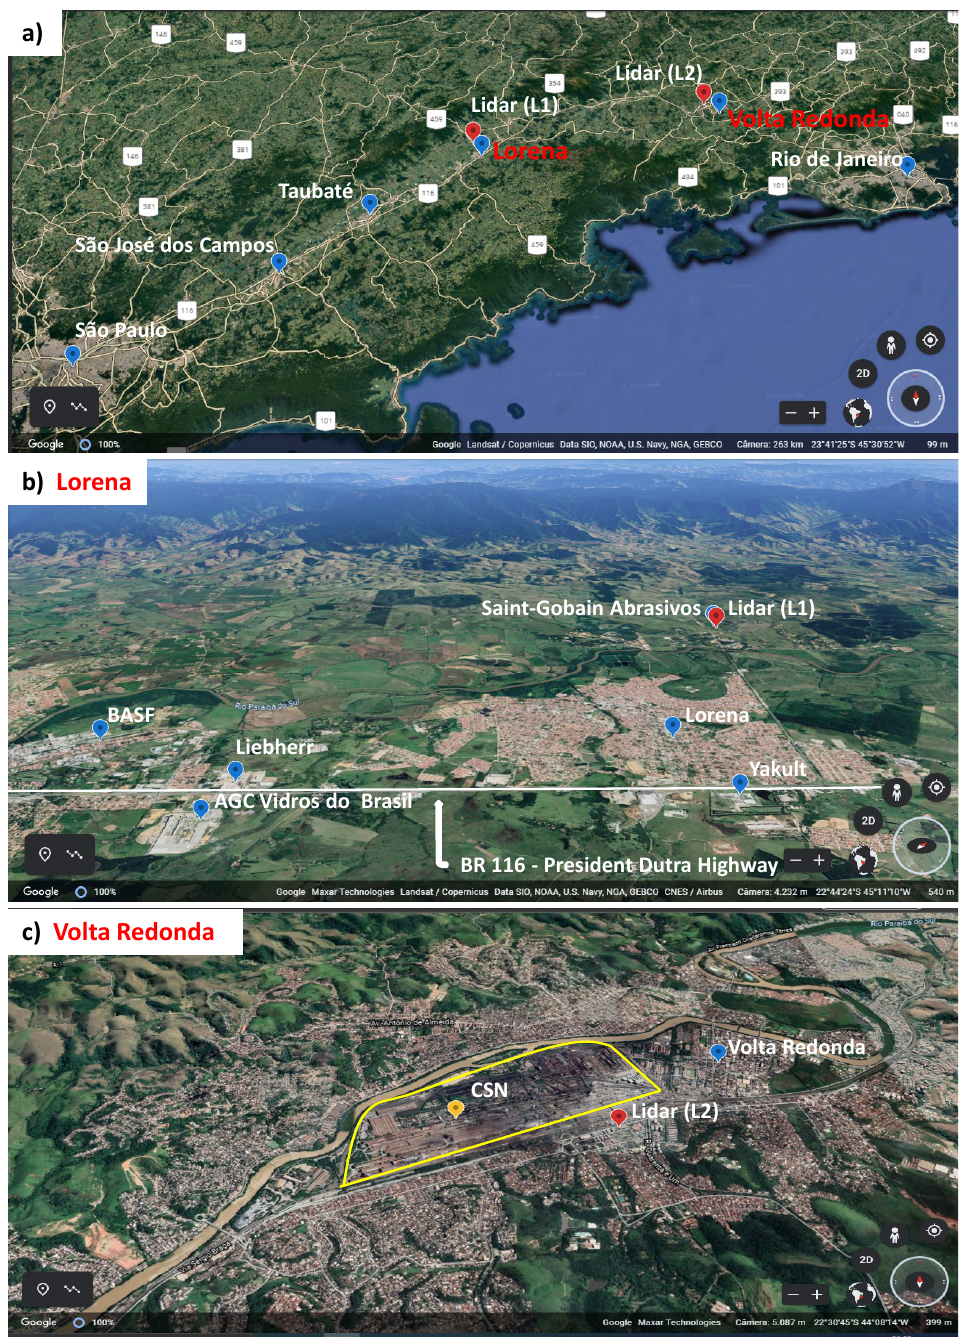
Figure 1. ( a ) Map of the region of the Paraíba valley with Lorena and Volta Redonda marked in red color. The Rio de Janeiro and São Paulo cities are also marked, as well as other important regions along the Presidente Dutra highway. ( b ) Lorena local map showing the lidar position (red pin) and nearby companies. ( c ) Volta Redonda local map. The lidar location is marked by a red pin while the yellow contour indicates the CSN area. One of two blast furnaces of the company, marked by a yellow pin, is 700 m away from the lidar